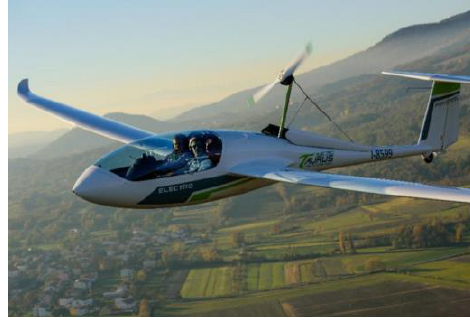
Fig. 3. Taurus Electro motor-glider [10]